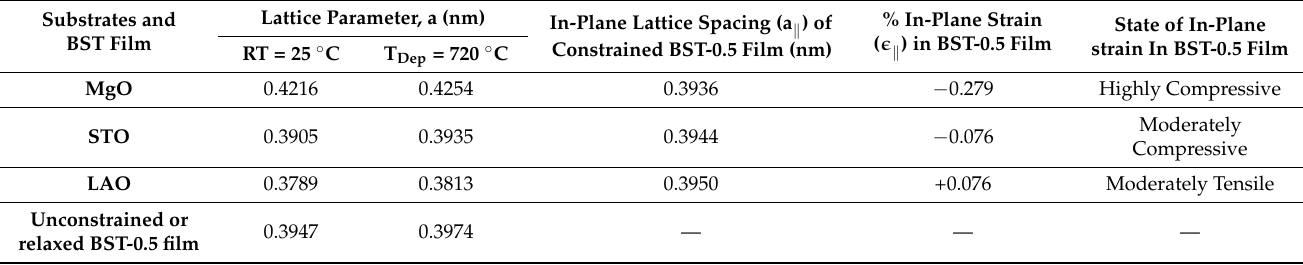
Table 2. In-plane lattice parameters ( a (cid:107) ) and percent (%) in-plane strain (biaxial compressive or tensile) at RT in constrained BST-0.5 films deposited on single crystal substrates. The cubic lattice spacing of unconstrained BST-0.5 thin film at RT ( a RT ) and 720 ◦ C (a 720 ◦ C ), as well as for substrates at these temperatures are taken from Table 1. Substrates and BST Film